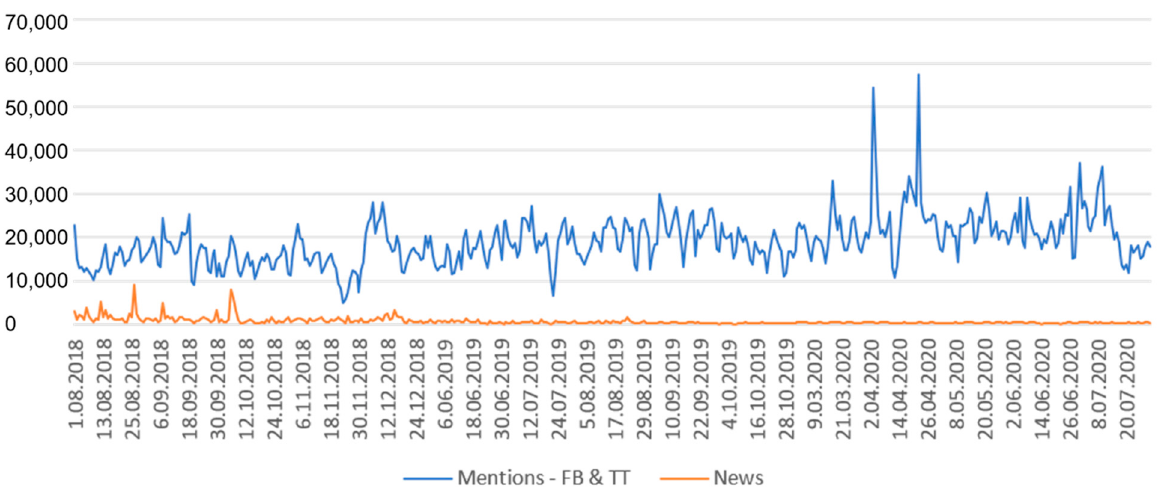
Figure 1. Time distribution of environment-related posts and news items.